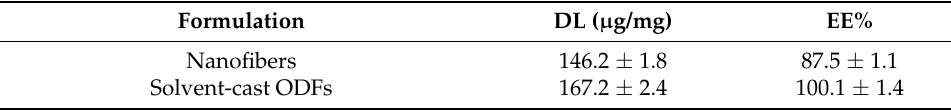
Table 1. DL and EE% ( ± SD) of the drug-loaded formulations ( n =